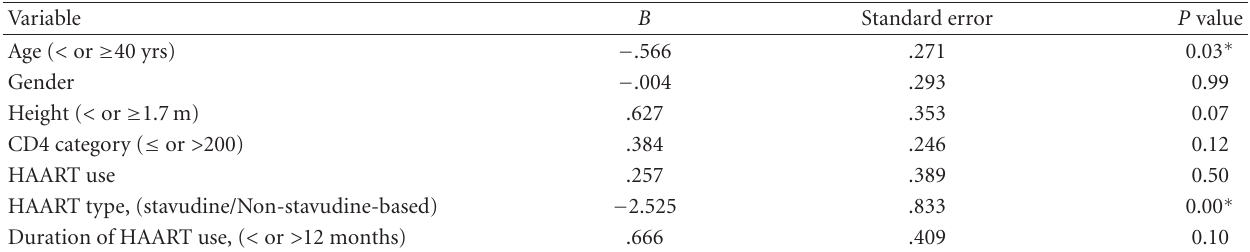
Table 3: Determinants of occurrence of HIV-sensory neuropathy using multivariate regression